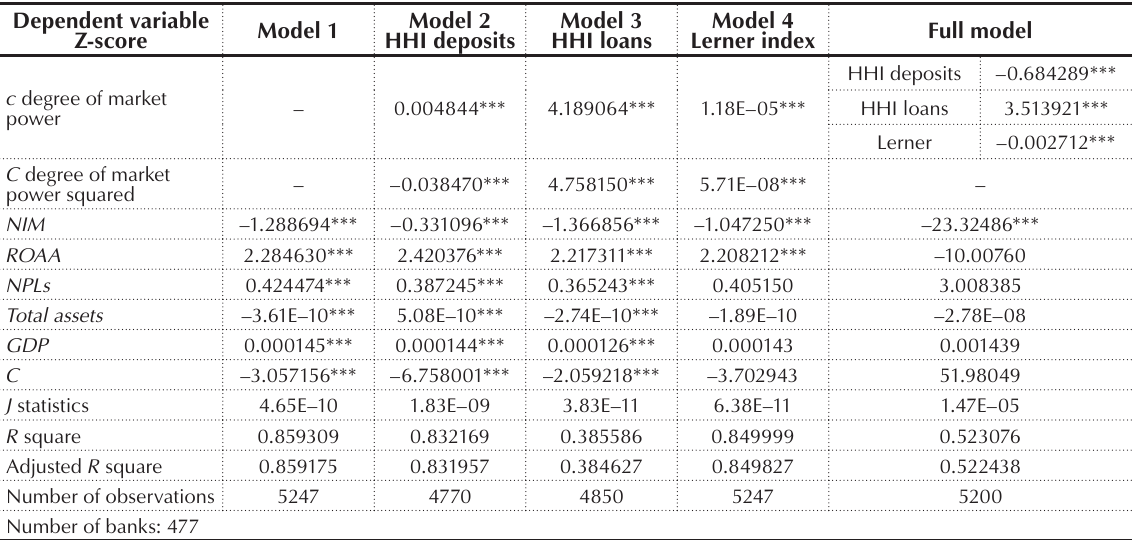
Table (cid:1006). (cid:68)(cid:381)(cid:282)(cid:286)(cid:367)(cid:400)(cid:859)(cid:3)(cid:396)(cid:286)(cid:336)(cid:396)(cid:286)(cid:400)(cid:400)(cid:349)(cid:381)(cid:374)(cid:3)(cid:381)(cid:437)(cid:410)(cid:272)(cid:381)(cid:373)(cid:286)(cid:400)(cid:3)